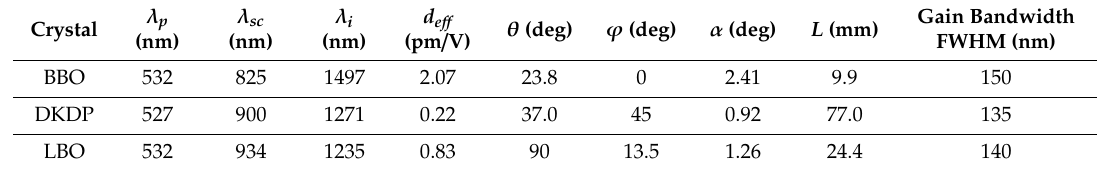
Table 5. UBB NOPA phase-matching parameters in non-linear crystals.